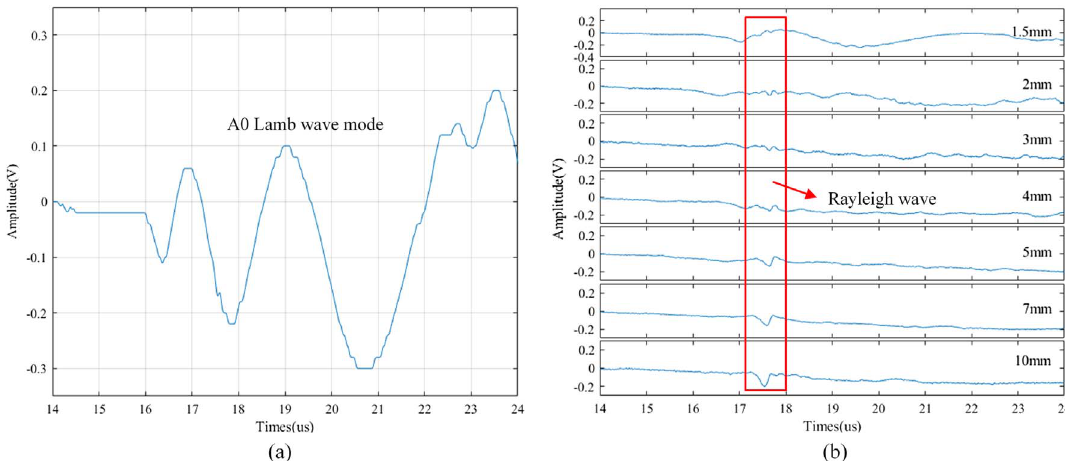
Figure 5. (a) The A0 Lamb wave mode detected at 1 mm thickness. (b) Measurement results at different thicknesses.